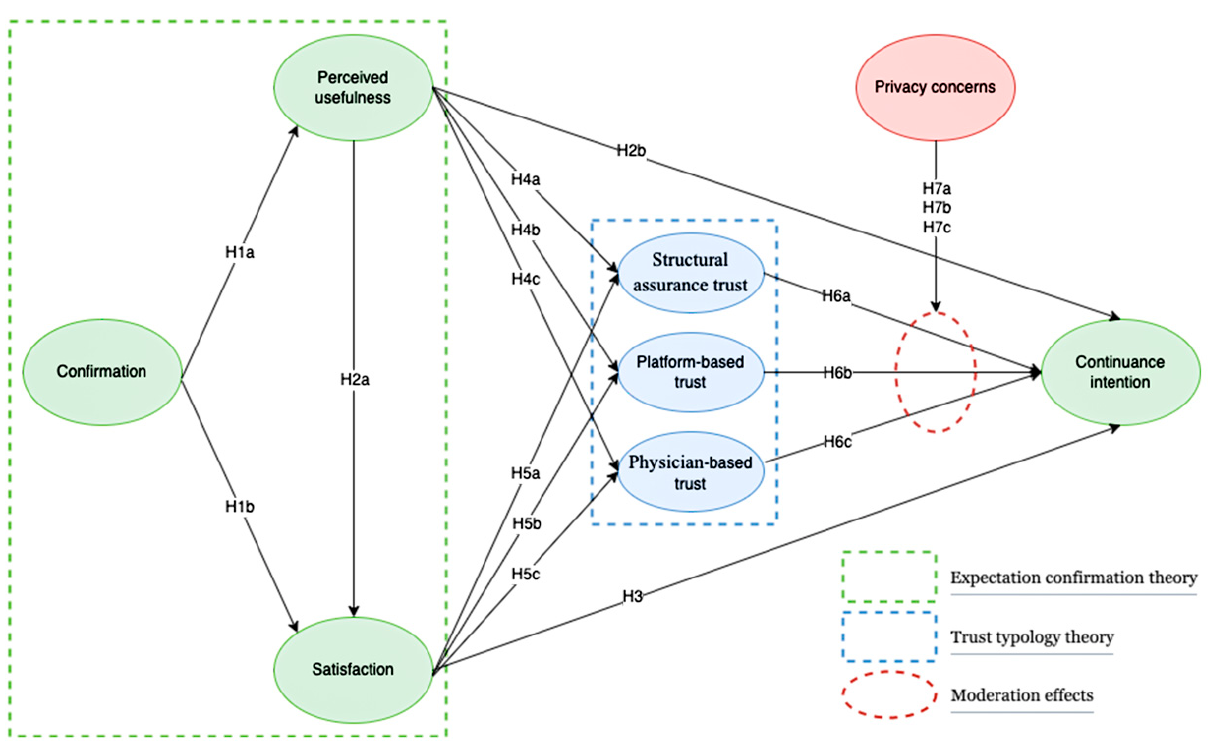
Figure 1. Research model.